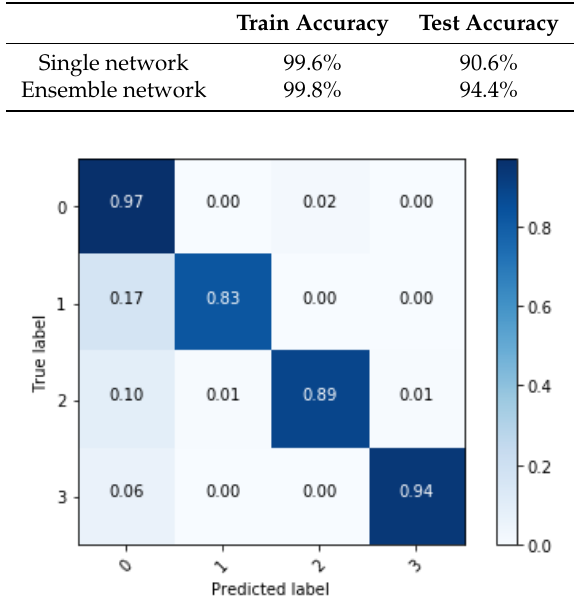
Table 3. Classification accuracy of the single network and the ensemble network.